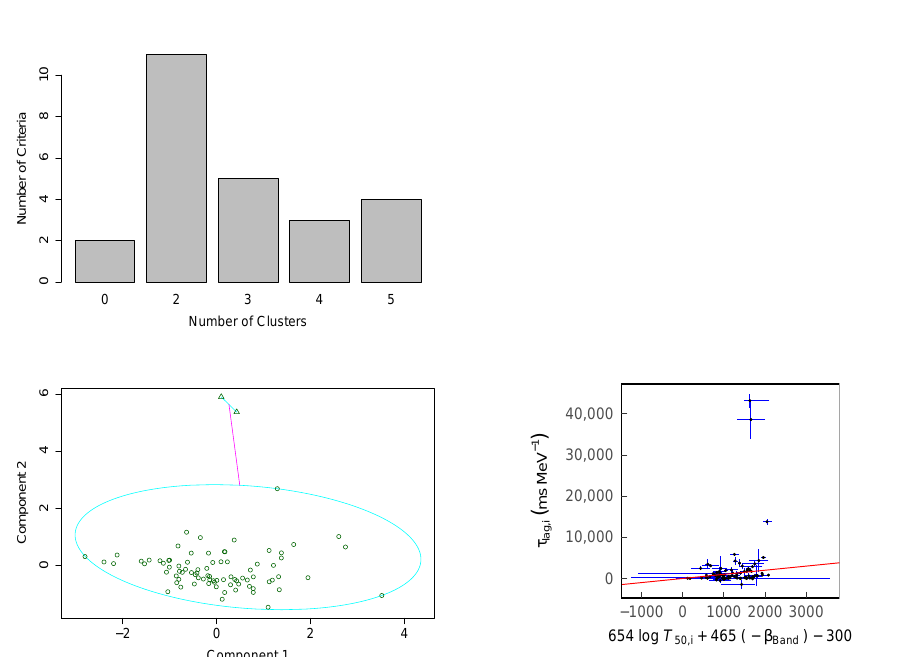
Figure 1. The outlier plot for the three parameters, τ lag,i , T 50,i and β Band . The histogram is the result of function NbClust, indicating the best cluster number is 2. The left panel shows the PAM result for the clustering analysis. Notice the x and y axes (compnent 1 and 2) are the two principal components in the PAM method and do not represent any combination of the three parameters. The right plot shows the regression result of the physical parameters without outliers. The outliers are GRBs 980425B and 030528A. The linear regression result is τ lag,i = ( 654 + 150 − ) . The adjusted R 2 is 0.07. The red line is the best fit result, i.e., y = x . ( 300 + 400 − 940